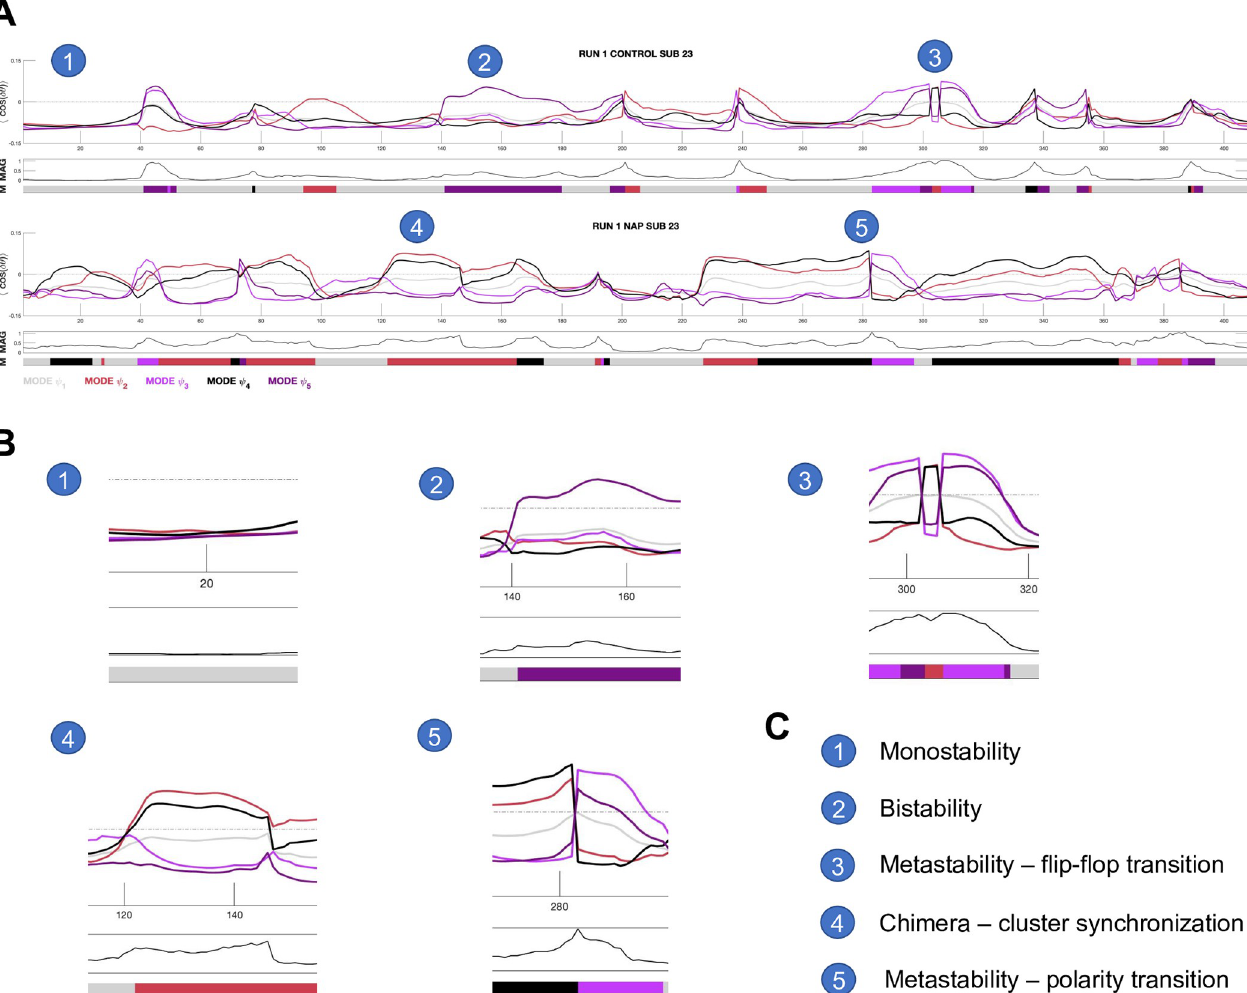
Fig 1. Diversity of phase-locking behavior. A) Time-series of mode eigenvectors from two subjects from the HCPEP dataset. Top panel shows phase-locking behavior. Middle panel shows instantaneous magnetization which is the ratio of in-phase to antiphase regions. Bottom panel shows the mode assigned to the timepoint from k-means clustering. Interesting behavior is indicated with numbered circles. B) Blow-outs for points 1 to 5. C) Legend for the numbered circles. MAG, magnetization; M, mode. Gray dotted line shows where phase-locking is equal to